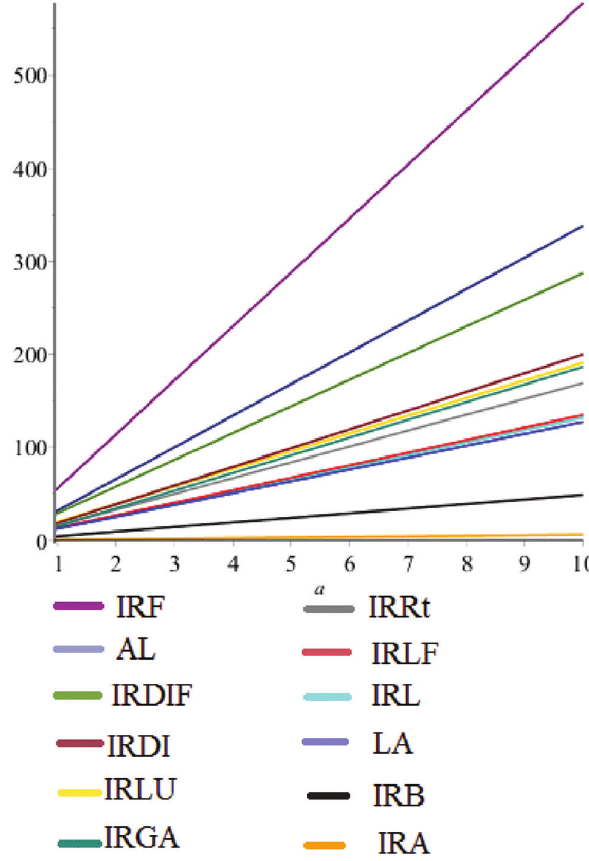
Figure 4: Comparison graph of irregularity topological indices of 2D CoBHT(CO) lattice.